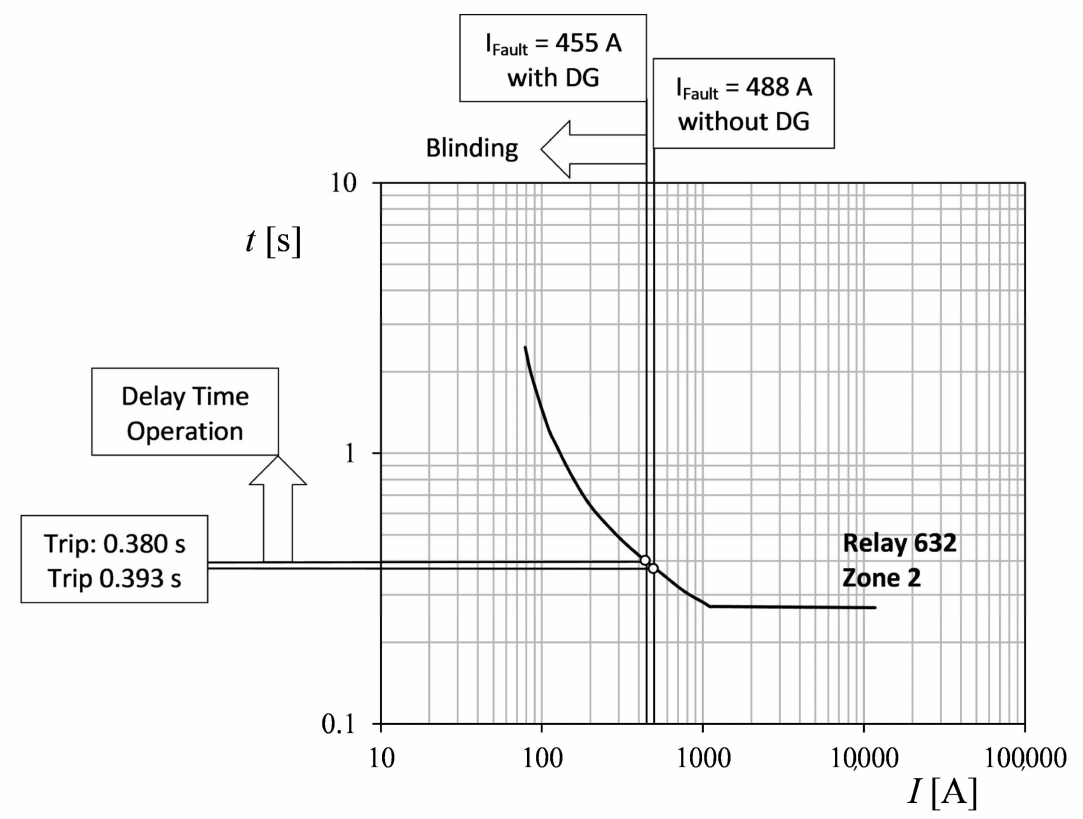
Figure 7. Protection Zone 2 current-time ( I-t ) performance of in case of a three-phase short-circuit at point F1, with 50% DG power (2 MW) at bus 633 (see Figure